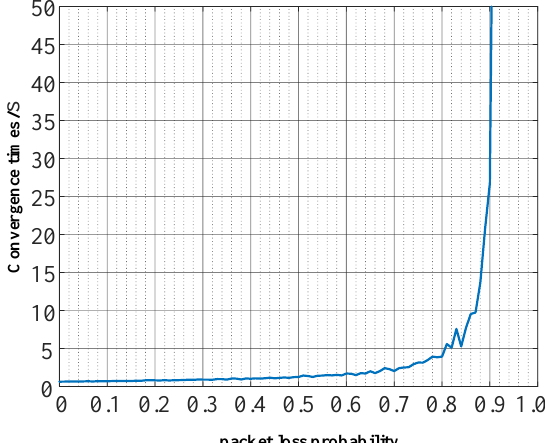
Figure 7. Convergence times of the system for different values of packet loss probability.